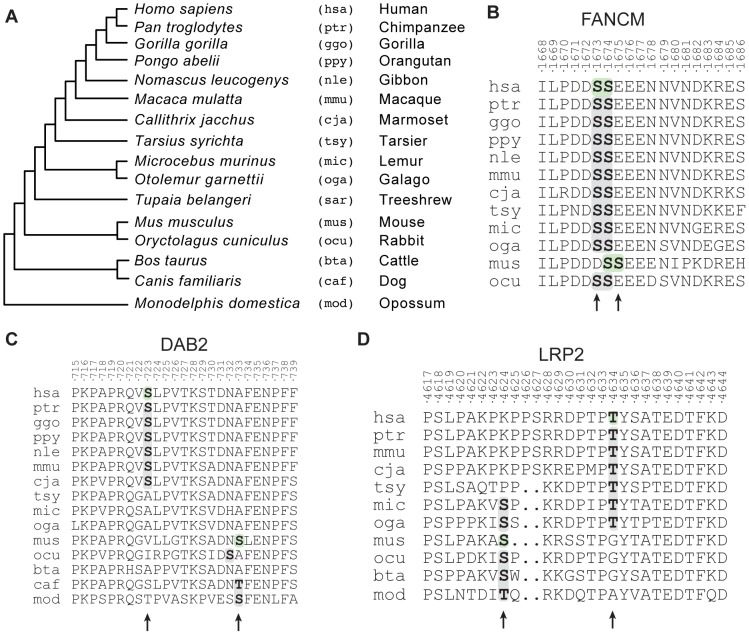
Evolutionary histories of candidate functionally redundant site pairs.(A) Phylogeny of the species considered for the analysis of evolutionary clustered sites. For all species we show the species name, the three-letter identifier and the common name. (B) Alignment of the Fanconi anemia group M protein (FANCM). Evolutionary clustered sites are indicated in bold. Residues that have been reported to be phosphorylated are on a green background. (C) Alignment of the disabled homolog 2 protein (DAB2). (D) Alignment of the low-density lipoprotein receptor-related protein (LRP2).